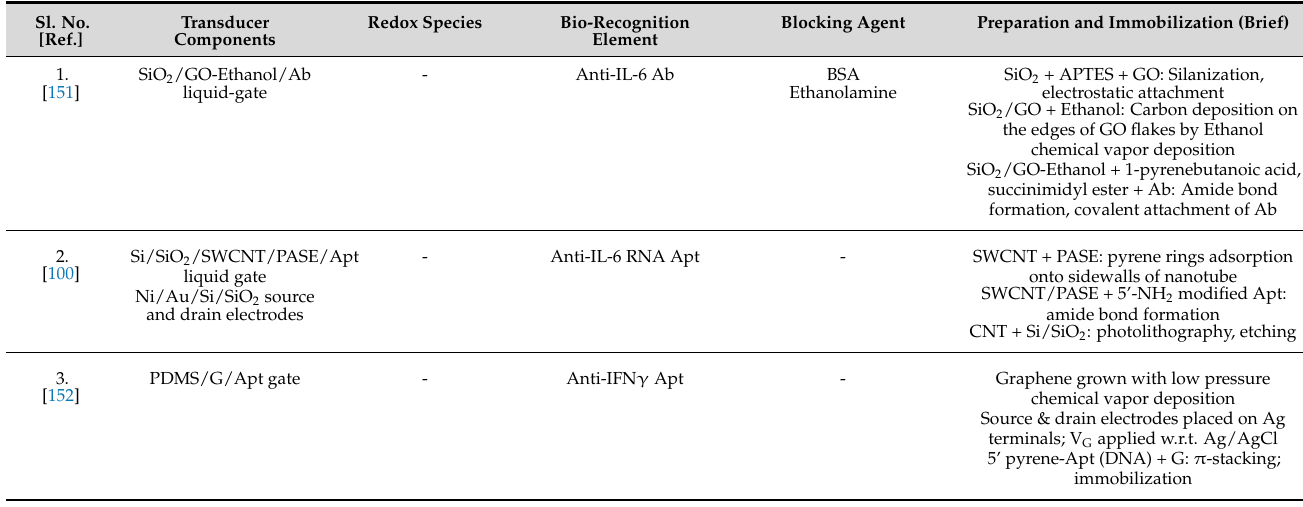
Table 15. FET-based biosensors: Design and sensor preparation. Sl. No.